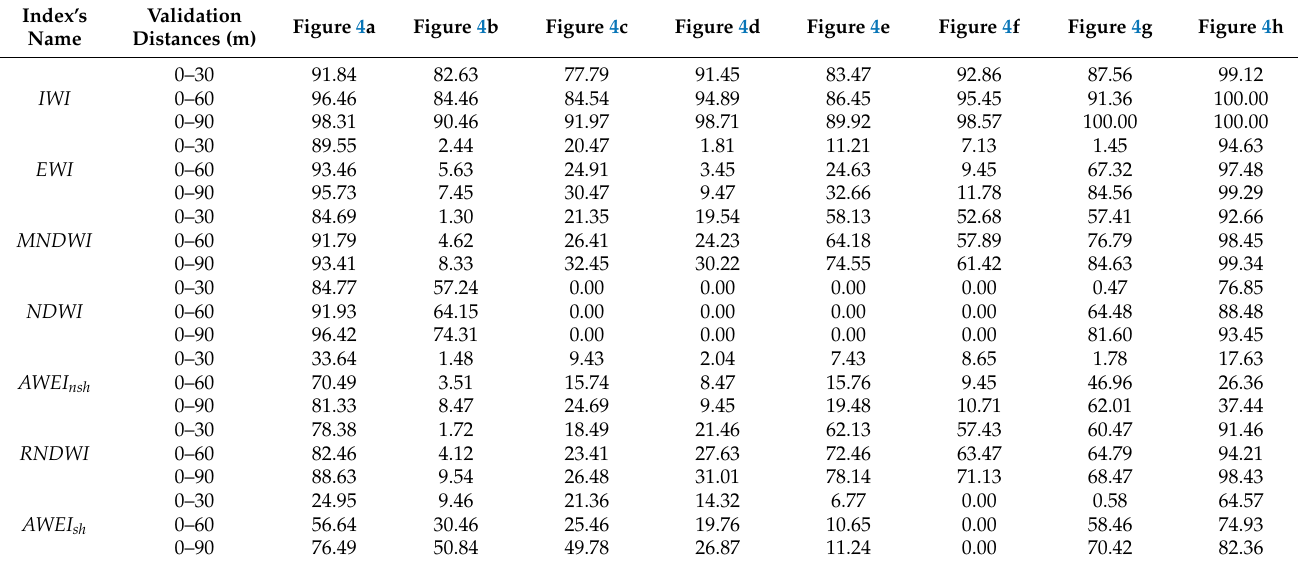
Figure 4. Diagram of partial results of different coastline types extracted for each index: ( a , d , g ) the artificial shore area; ( b ) the sandy shore area; ( c , d , e , f ) the silty shore area; ( g , h ) the enclosed mariculture shore. Table 4. Accuracy analysis of the local coastline results (%) for different